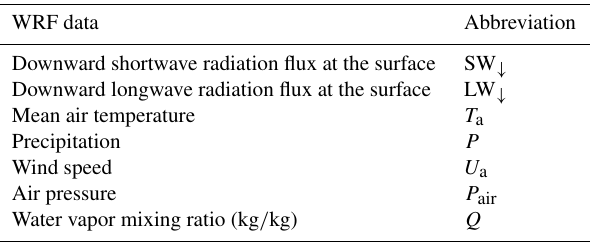
Table 3. WRF data used to derive forcing data for the snow model. WRF data